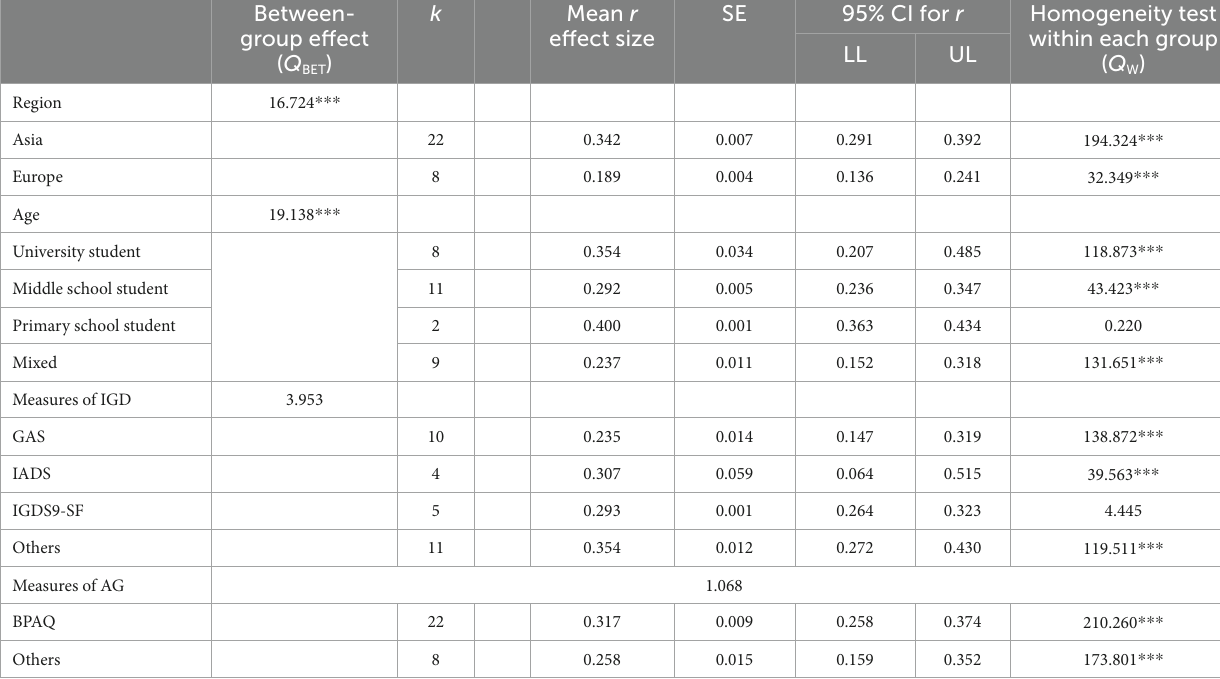
TABLE 3 Region and age and measures moderators of the association between IGD and AG.